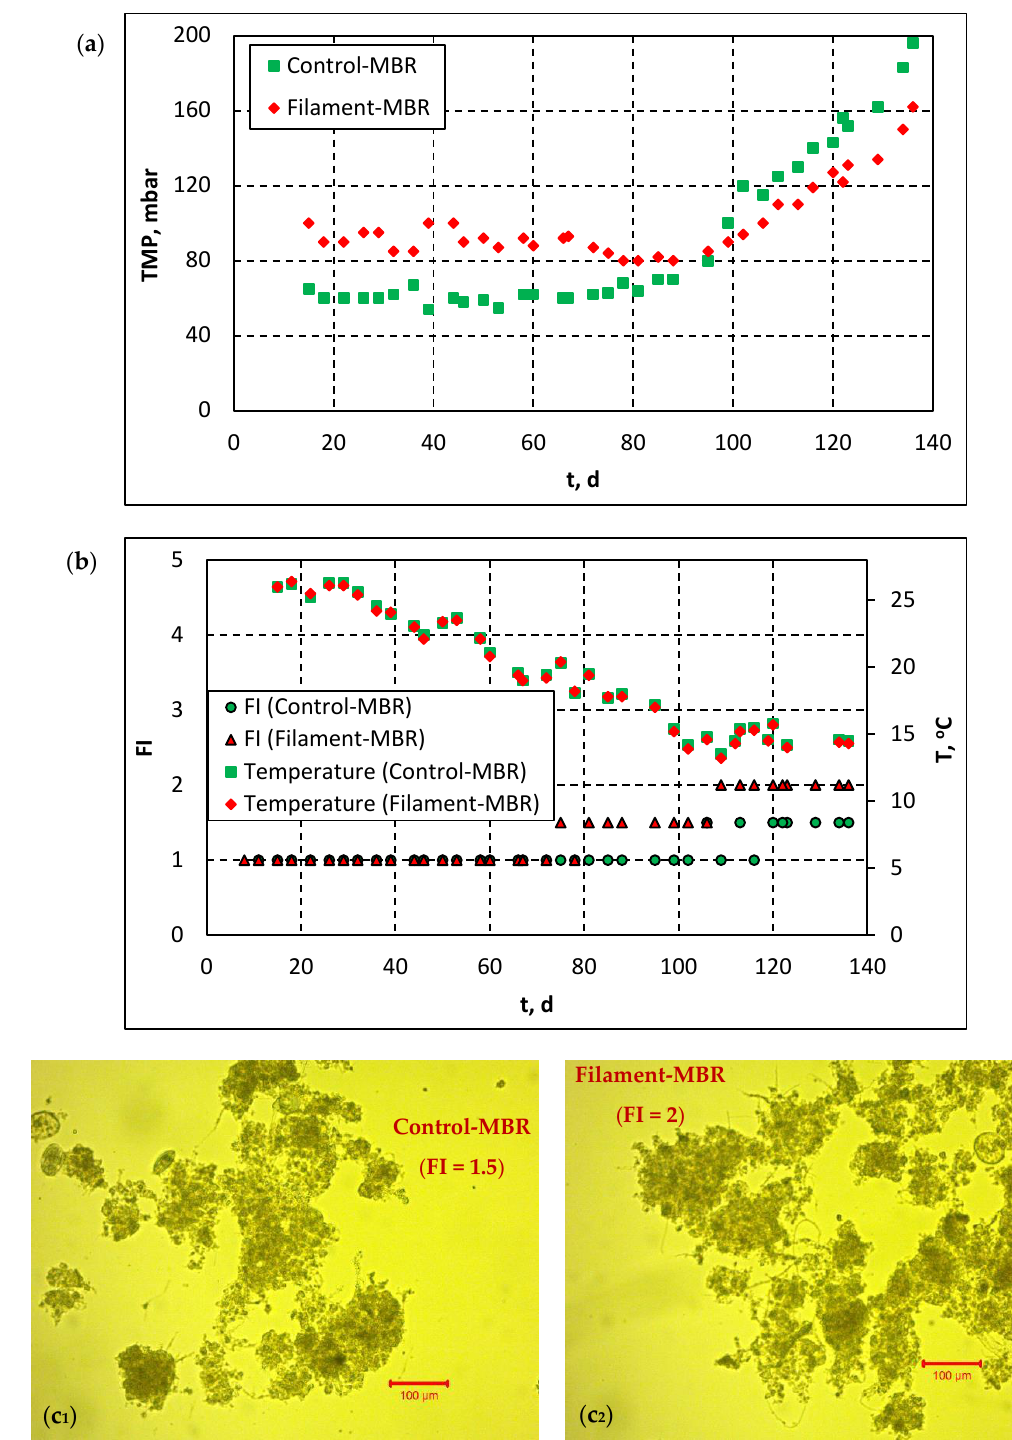
Figure 2. ( a ) Development of TMP during the pilot-scale MBR operation, ( b ) evolution of FI and temperature during the pilot-scale MBR operation and ( c ) indicative FI observation images with optical microscopy (134th day of operation of the pilot-scale MBR).